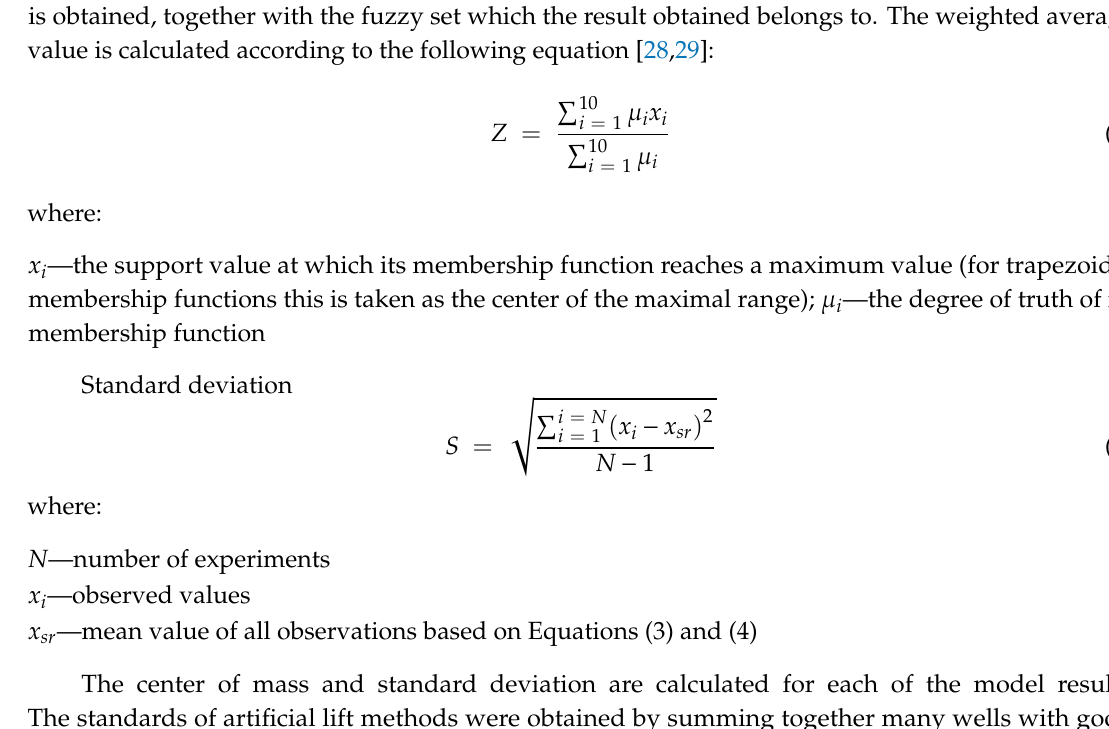
Table 6. Center of mass and standard deviation values for each of the